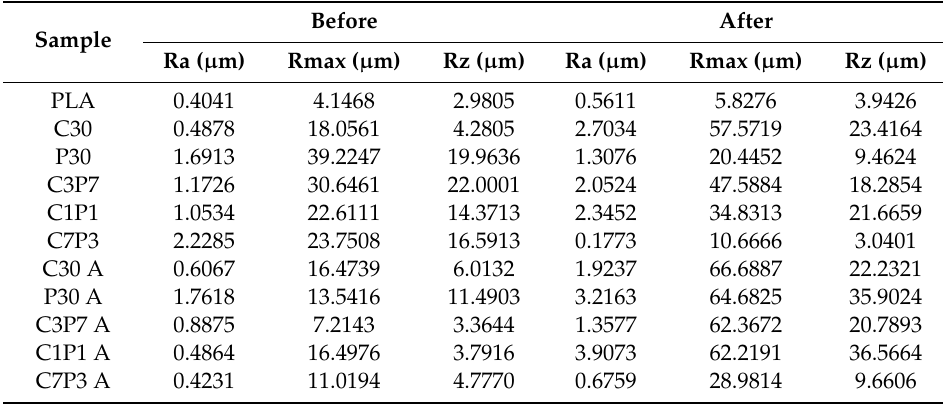
Table 4. Surface texture measurements: roughness parameter summary sheet of untreated and alkali-treated CF / PALF / PLA